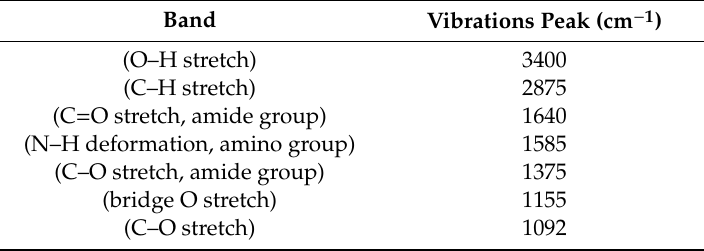
Figure 2. Attenuated total reflectance Fourier-transform infrared (ATR-FTIR) spectra of the reference sample ( a ), S1 ( b ), S2 ( c ), and S3 ( d ). Table 3. Bands and characteristic peaks of